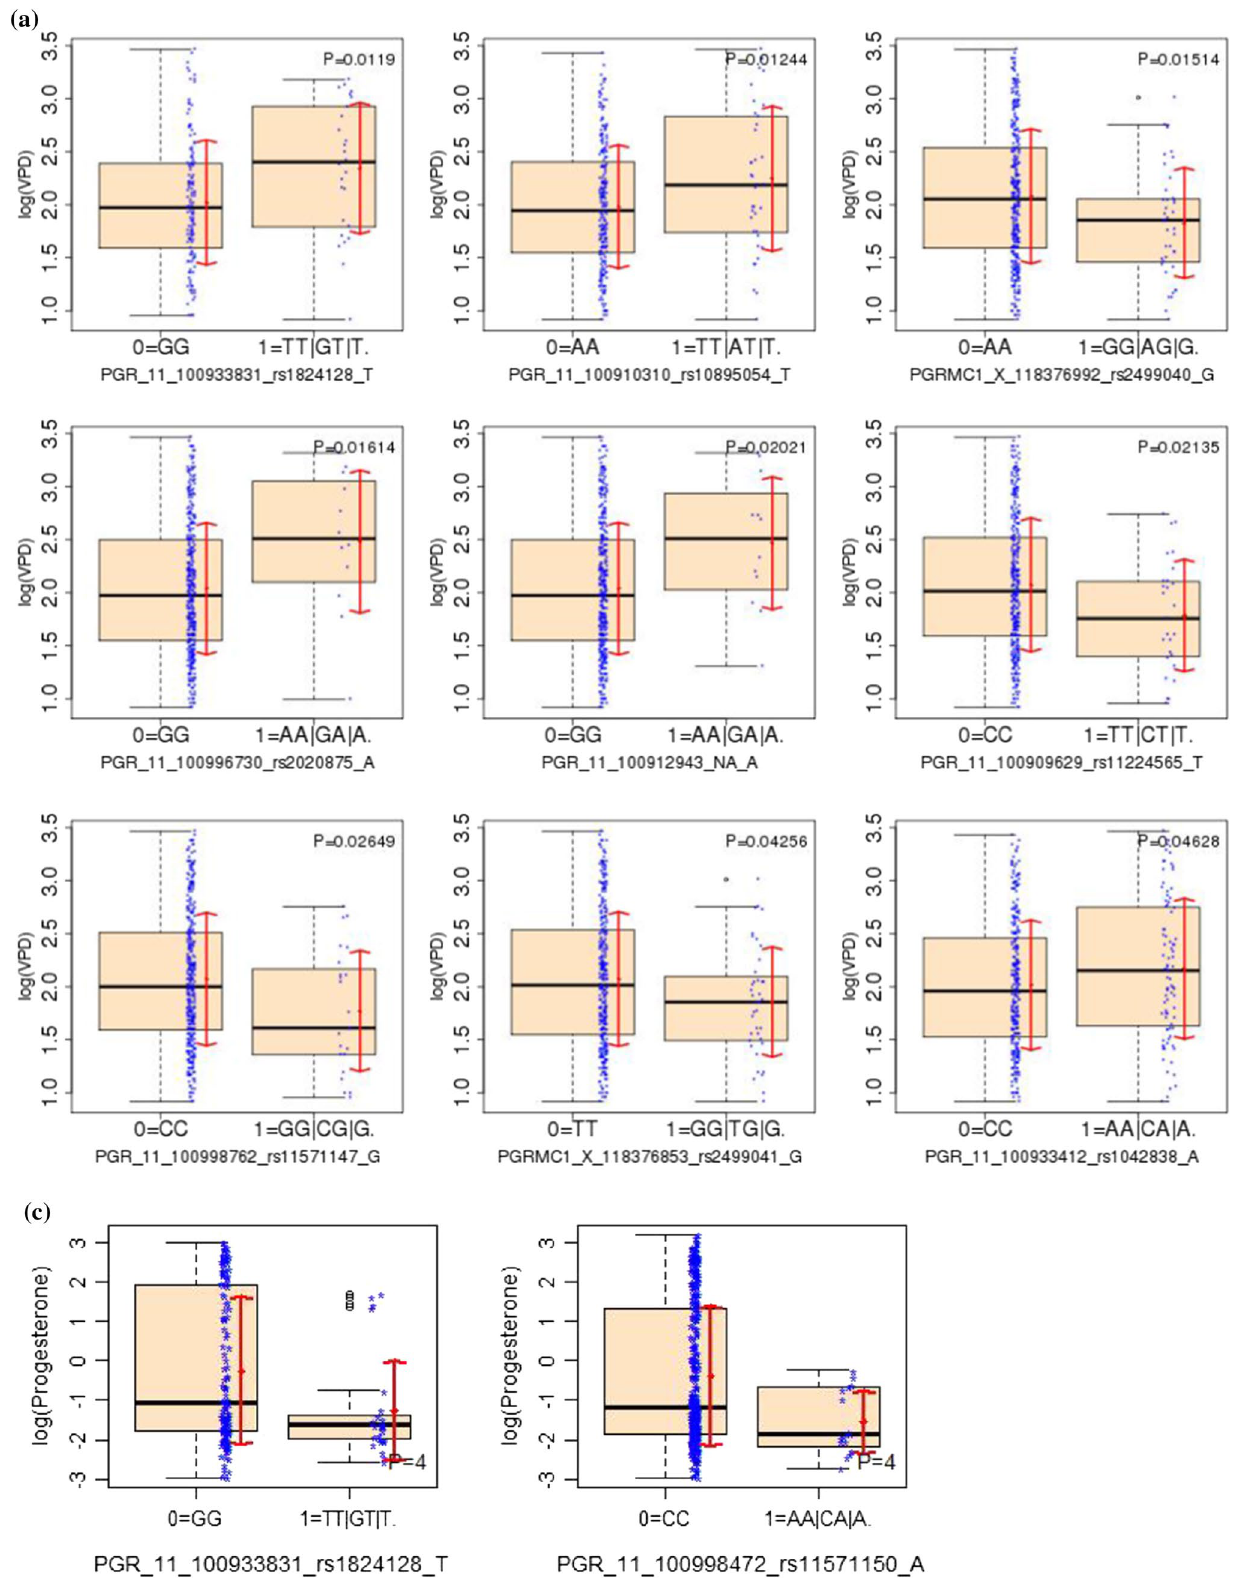
Fig. 3 Single nucleotide polymorphisms (SNPs) associated with A volumetric percent density (VPD), B non-dense volume (NDV) and C circu- lating progesterone (cPgR) (all in log scale) from univariate linear